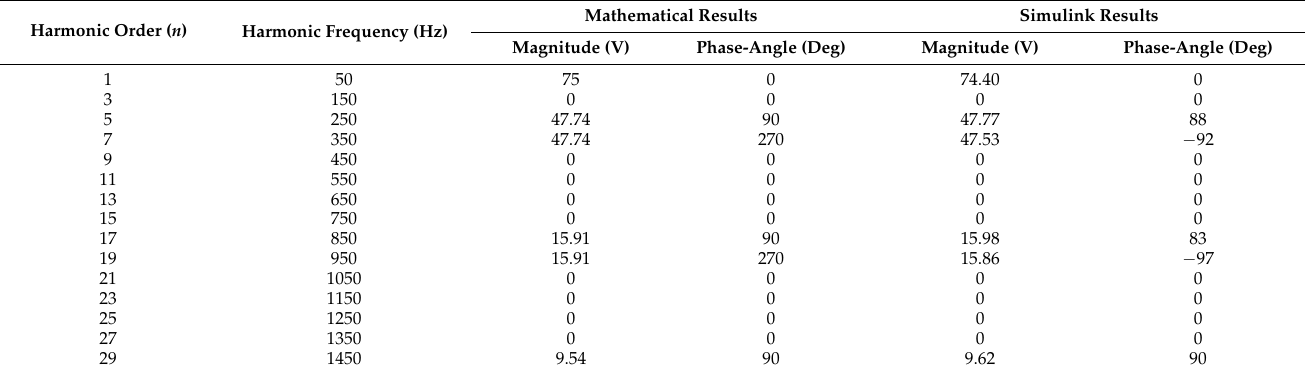
Table 5. Harmonic coefficients of output voltage control with PWM control.